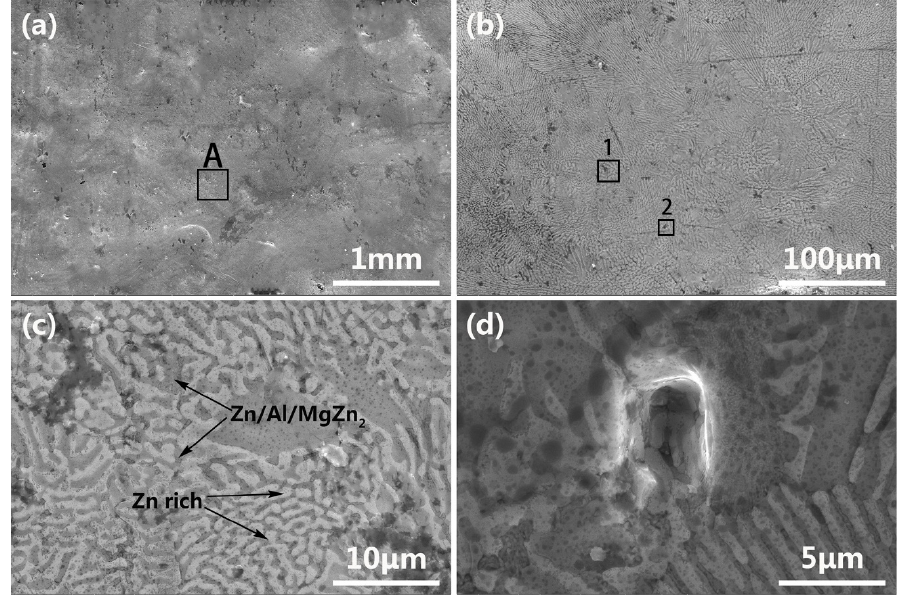
Figure 10. Microstructure of unpolished steel plate coatings at ( a ) low multiplications, ( b ) Enlarged image of area A in ( a ), ( c ) Enlarged image of area 1 in ( b ), ( d ) Microscopic image of region 2 in ( b ).